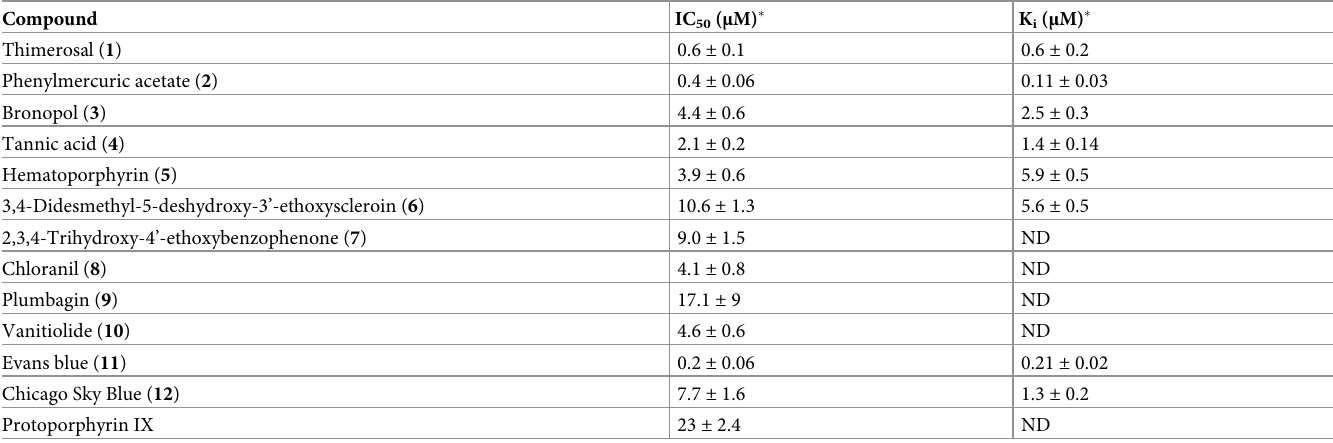
Table 1. IC 50 and K i values of SARS-Cov-2 M pro inhibitors.